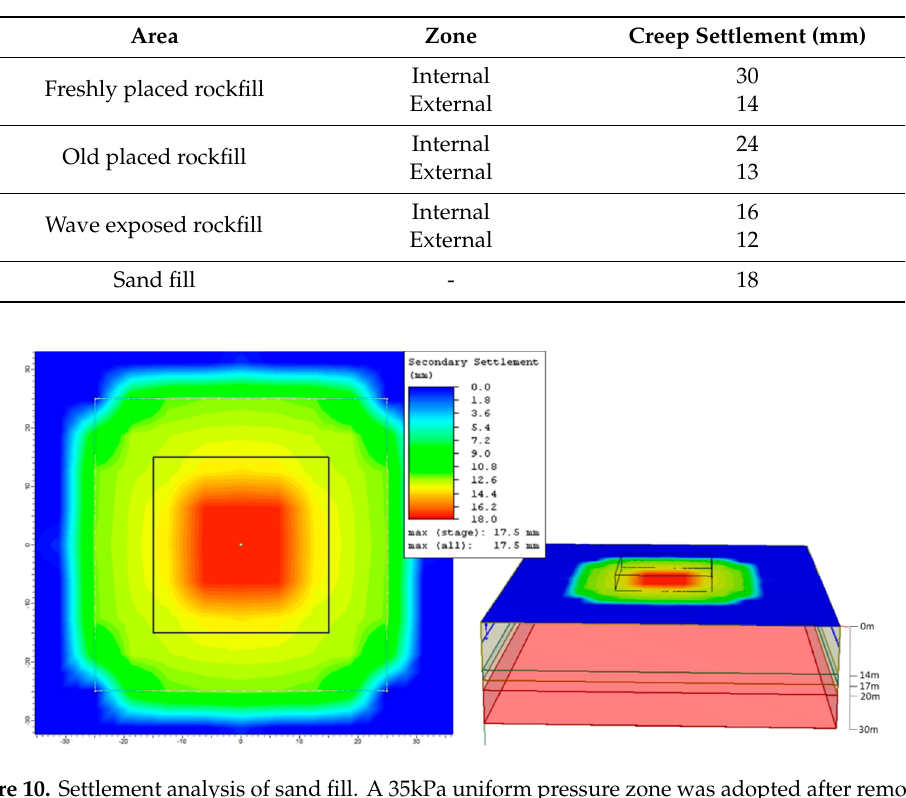
Table 6. Summary of Settle 3D creep settlement results over a period of 50 years.